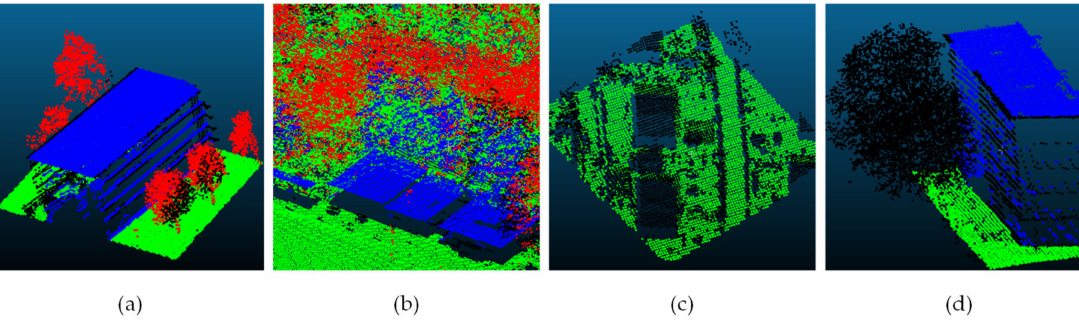
Figure 3. Incorrect labels in the point-in-polygon results. ( a ) Unlabeled building and tree points caused by datasets registration problem; ( b ) Mislabeled tree points as they are in the building polygon; ( c ) Unlabeled building points caused by missing building polygons; ( d ) Unlabeled tree points caused by missing vegetation polygons. Building, navy blue; tree, red; terrain, green; and unlabeled,